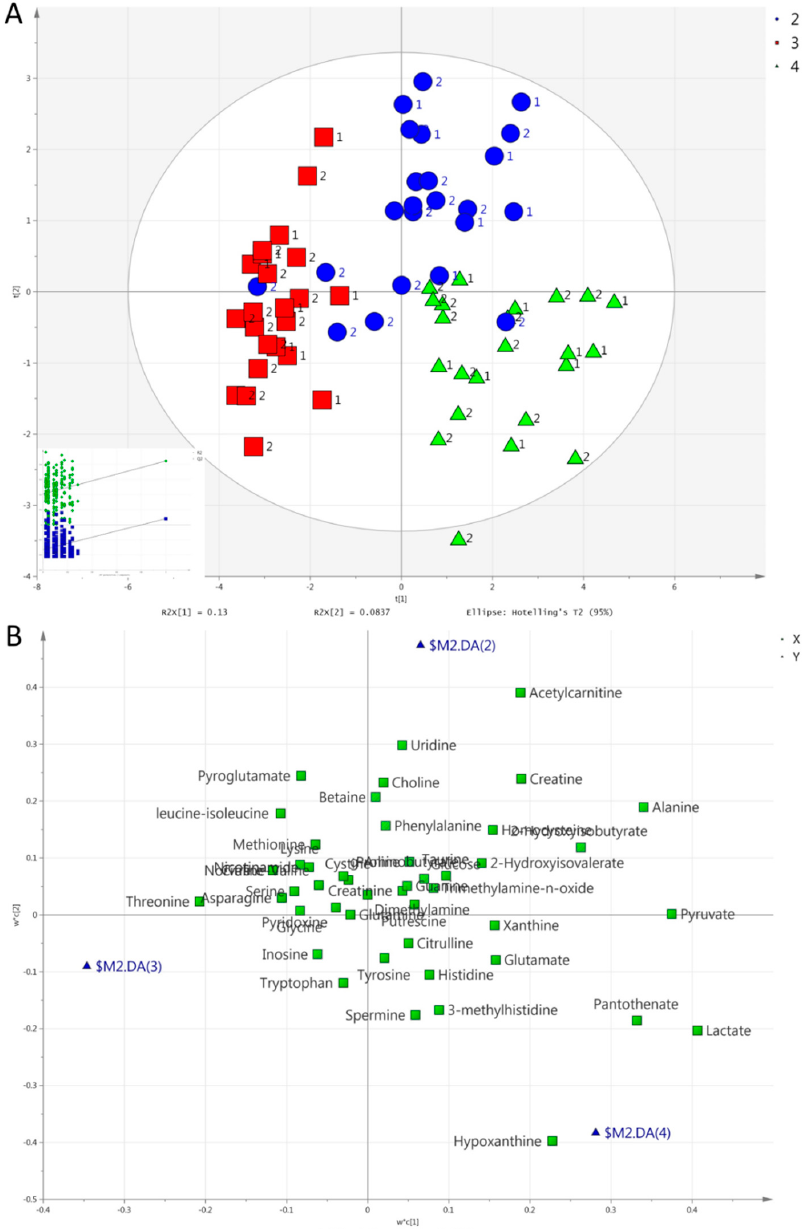
Figure 3. ( A ). Score plots concerning serum samples for the a partial least square discriminant analysis (PLS-DA) model comparing exercise modes at 1 h: HIIE (blue circles), CME (red squares), RE (green triangles). Inserts (subfigure) are permutation plots. The number 1 is used for the MetS group and 2 for the Healthy group. ( B ). Loading plot for the respective PLS-DA model. Blue triangles represent HIIE (2), CME (3), and RE (4).